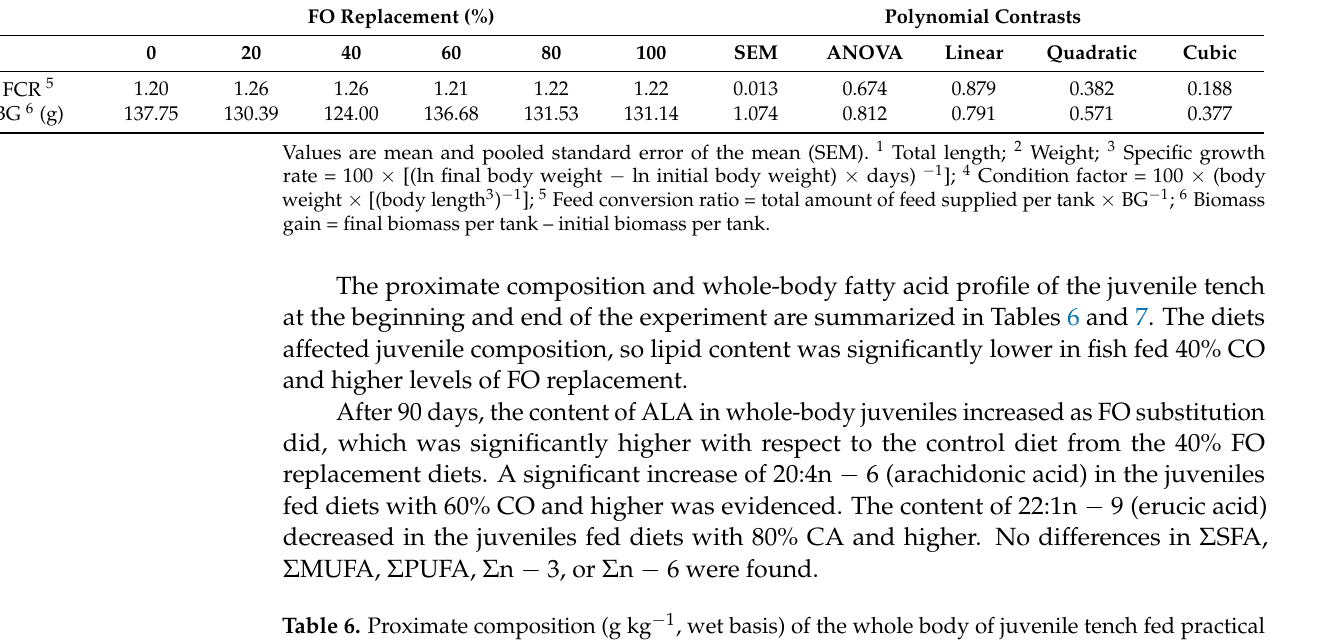
Table 6. Proximate composition (g kg − 1 , wet basis) of the whole body of juvenile tench fed practical diets with different replacements of cod liver oil (FO) by camelina oil (CO). FO Replacement (%)